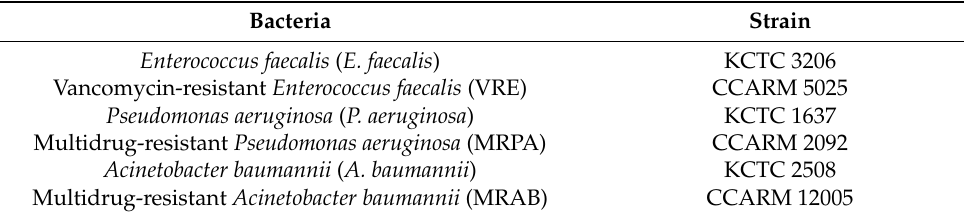
Table 2. List of microorganisms used for antimicrobial experiments.